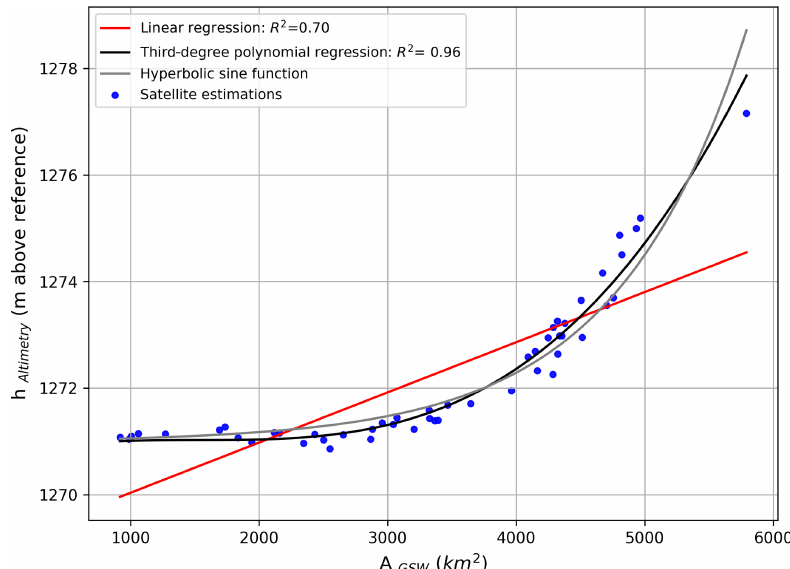
Figure 12. Relationship between A GSW and h Altimetry for Lake Urmia. Only 4 out of the 137 lakes showed a clear non-linear